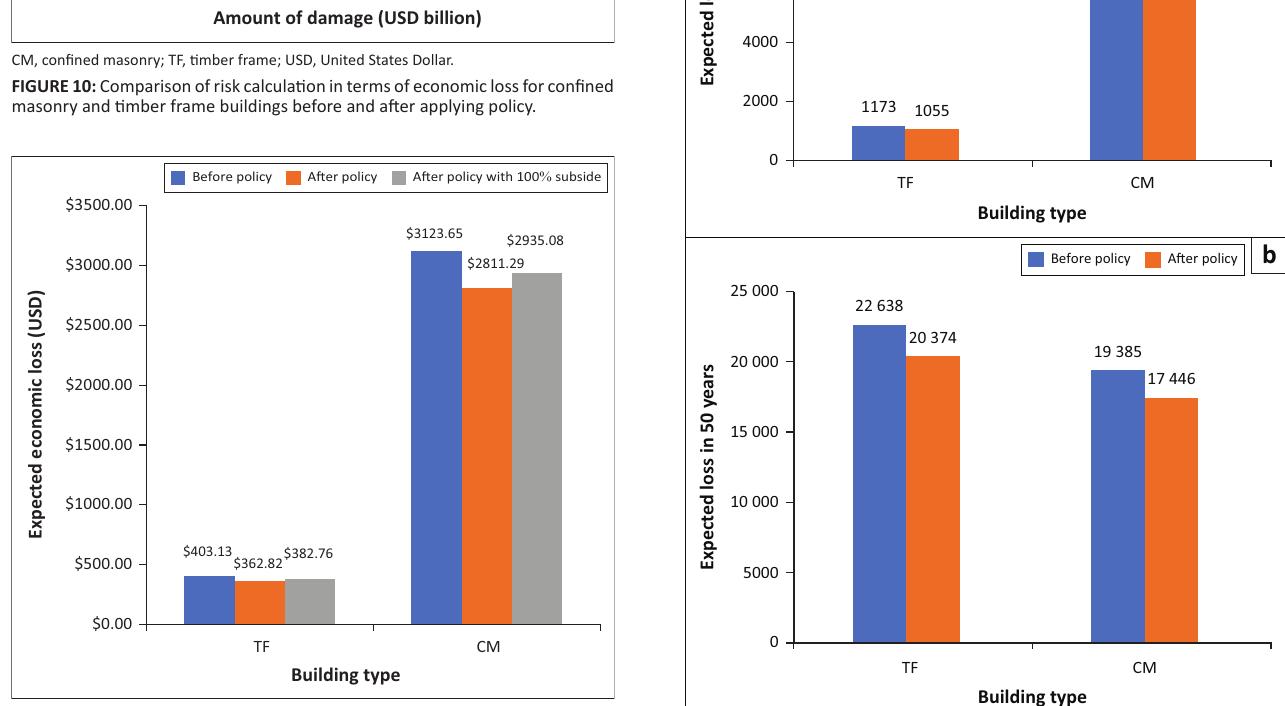
CM, confined masonry; TF, timber frame; USD, United States dollar. FIGURE 11: Comparison of expected economic loss for confined masonry and timber frame building before and after applying policy.